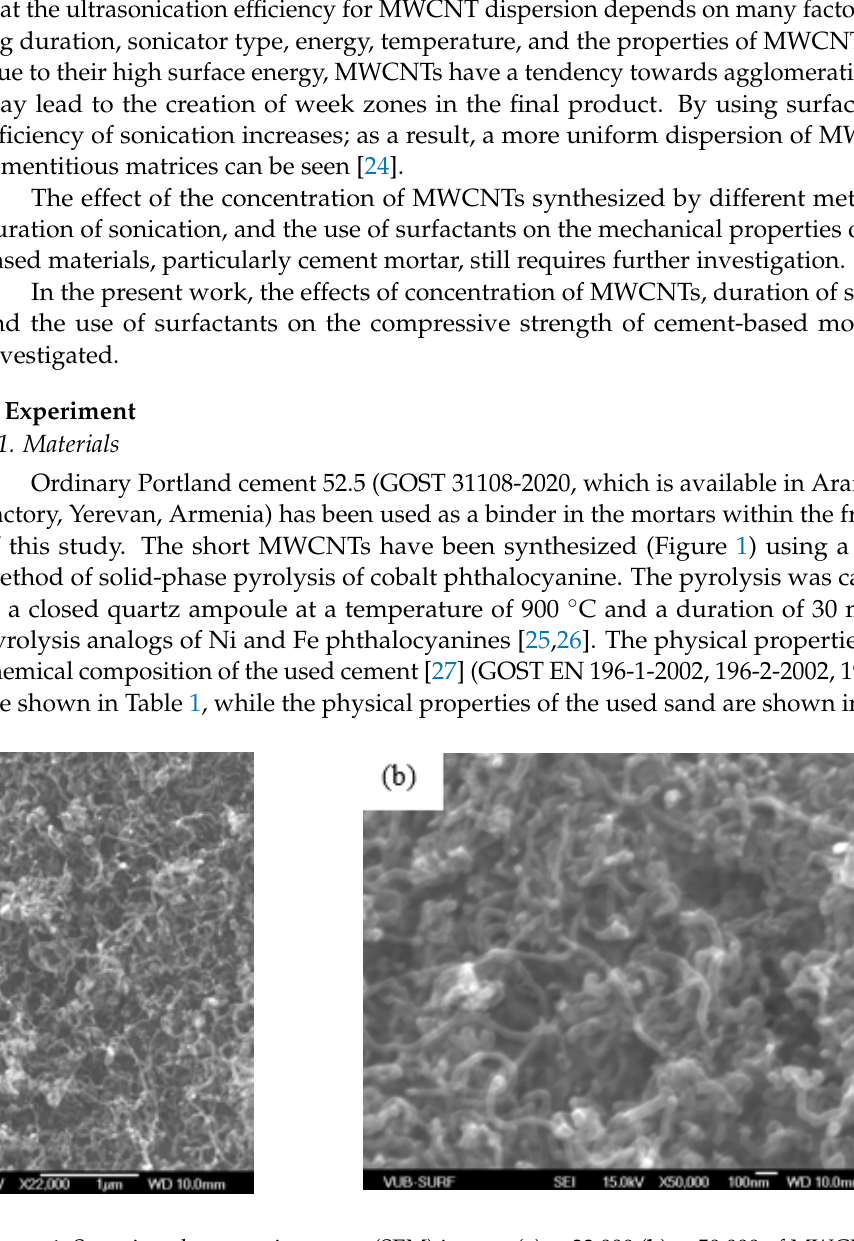
Figure 1. Scanning electron microscope (SEM) images ( a ) × 22,000 ( b ) × 50,000 of MWCNTs.